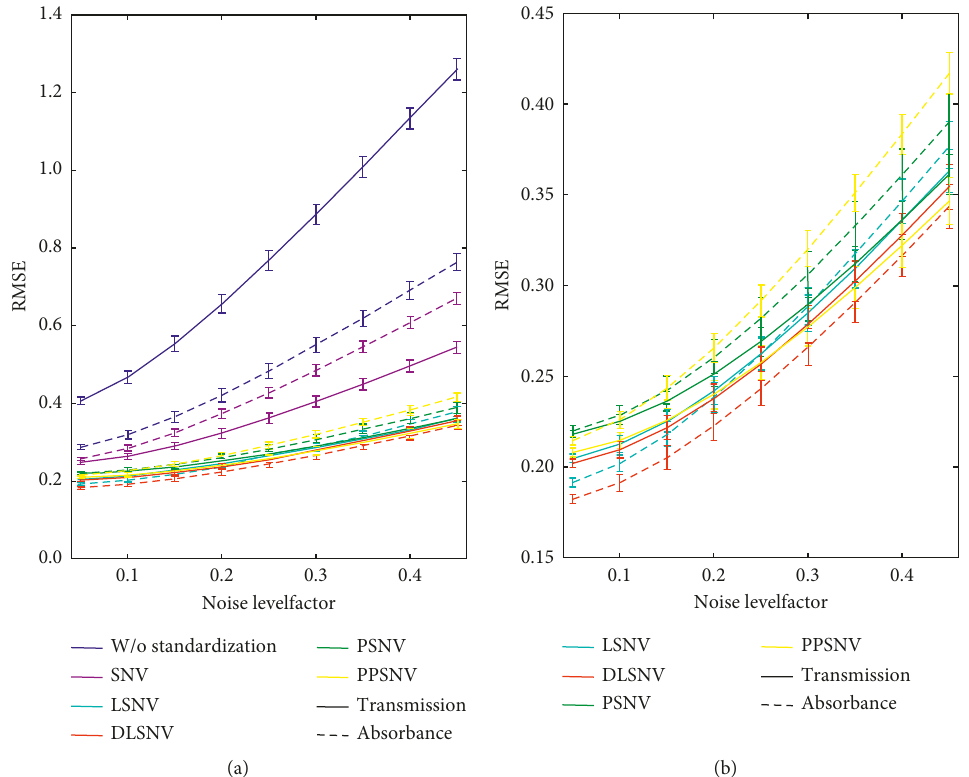
Figure 11: RMSE as a function of the noise level factor for the regression of the friction modifier compound of ATF A calibrated by the unperturbed full data set. The error bars represent the standard deviation of the prediction error calculated from the statistics of 50 repetitions of noise addition. In subplot (a), all curves are shown, and in (b), the sophisticated standardizations are